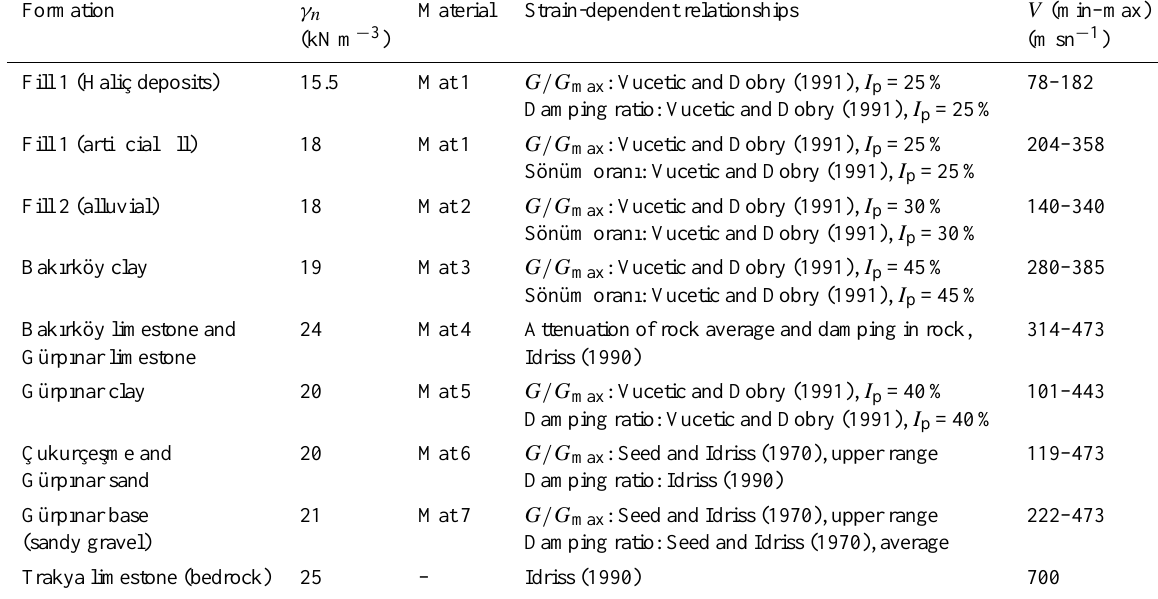
Table 2. Selected G/G max and damping relations for the